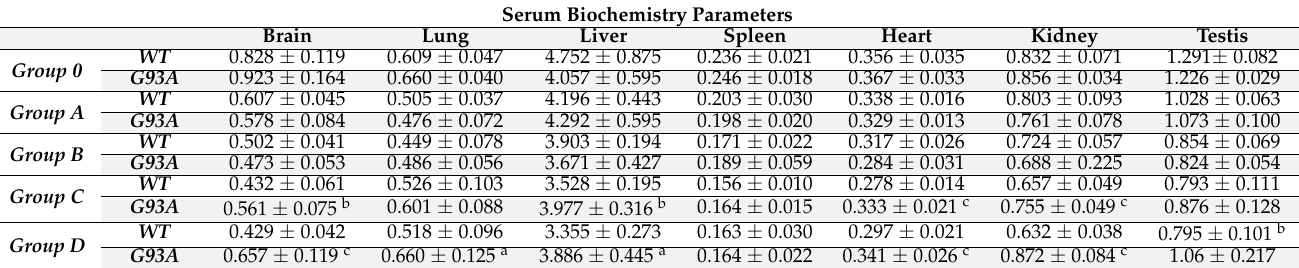
Figure 1. Body weights of the SOD1 G93A and SOD1 WT rats. All results were given as mean ± SD of n = 6–8 animals for each group. Notes: *** p ≤ 0.001, and **** p ≤ 0.0001. Table 1. Relative organ weight is represented by the percentage of body weight for each rat. All results were given as mean ± SD. a represents significantly different from SOD1 WT group ( p ≤ 0.05), b represents significantly different from SOD1 WT group ( p ≤ 0.001), and c represents significantly different from control SOD1 WT group ( p ≤ 0.0001).